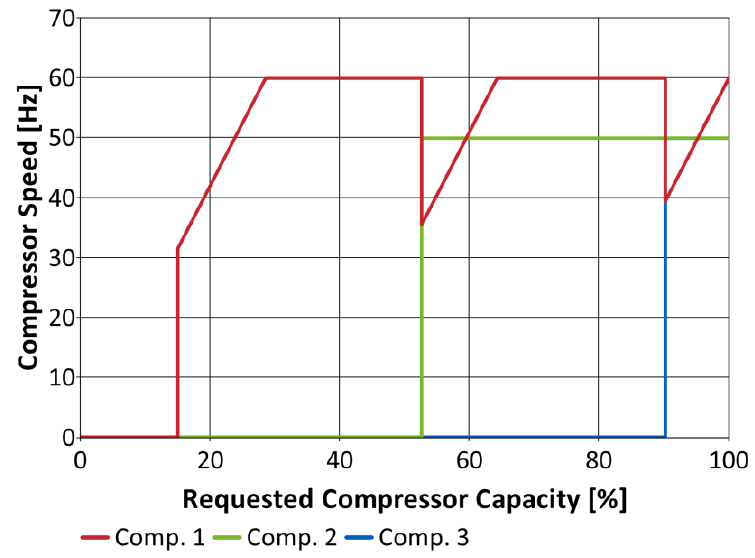
Figure 4. Course of the total compressor capacity resulting from both frequency- and on/off-controlled compressors (MT compressor group).